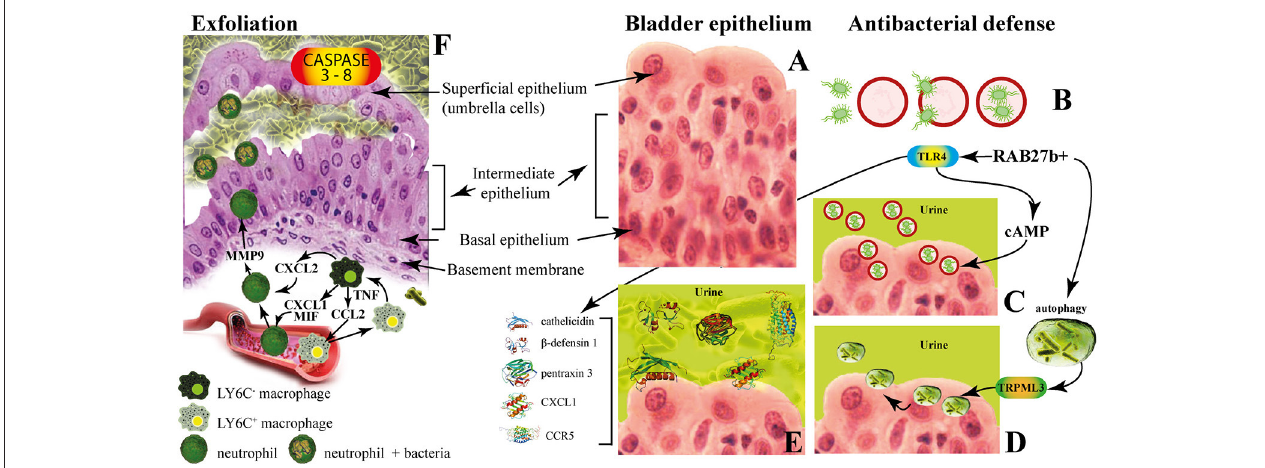
FIGURE 3 | The innate immune responses of bladder epithelium to bacterial infections. (A) The bladder epithelium; (B) adherent bacteria are internalized along with Rab27b + fusiform vesicles; (C) exocytosis of RAB27b + vesicles harboring UPEC and expulsion of the intracellular UPEC back into the lumen of the bladder; (D) transient receptor potential mucolipin 3 Ca2 + channel (TRPML3) triggers the spontaneous expulsion of the defective lysosomes and its contents out into the extracellular space; (E) soluble factors are also secreted by BECs, including antimicrobial peptides (AMP, such as cathelicidin and β -defensin 1), antimicrobial proteins [such as pentraxin 3 (PTX3)] and chemokines [such as CXC-chemokine ligand 1 (CXCL1) and CC-chemokine ligand 5 (CCR5)]. (F) Exfoliation is accompanied by rapid renewal of superficial BECs through active proliferation of basal progenitor mast cells. Intimate crosstalk between macrophages ensures the precise initiation of neutrophil